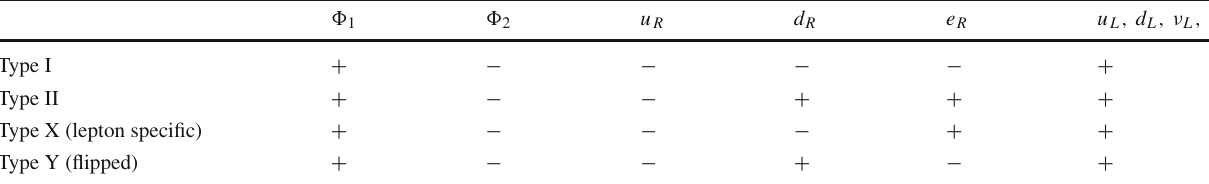
Table 1 Z 2 charge assignments that forbid tree-level Higgs-mediated FCNC effects